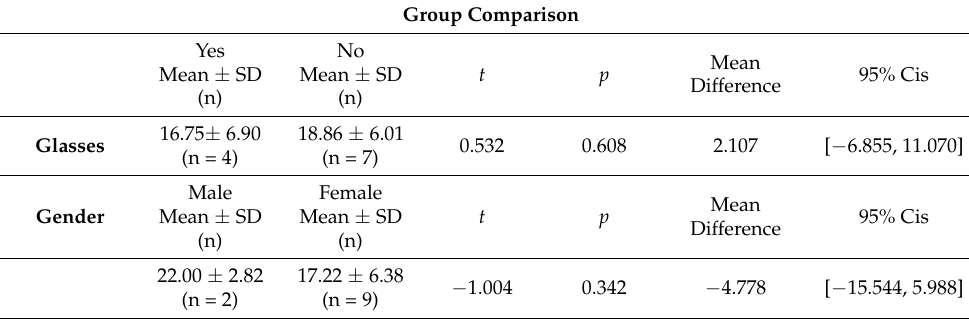
Table 4. Group Comparison (independent t-test).